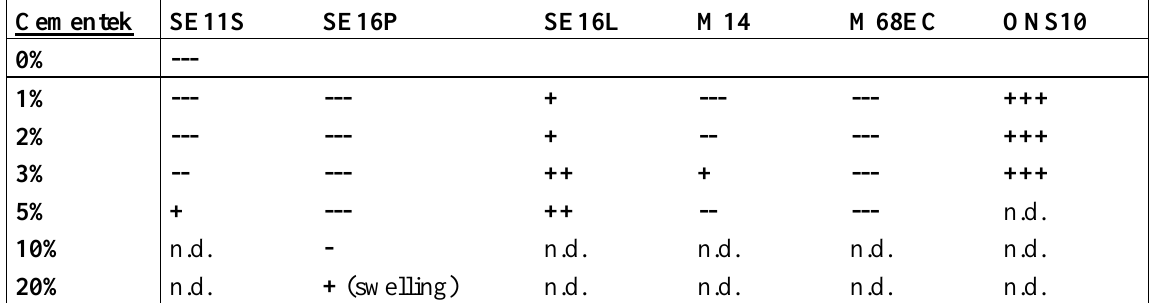
Table 4. Disintegration of Cementek in water (―ball‖ shaped). Cementek